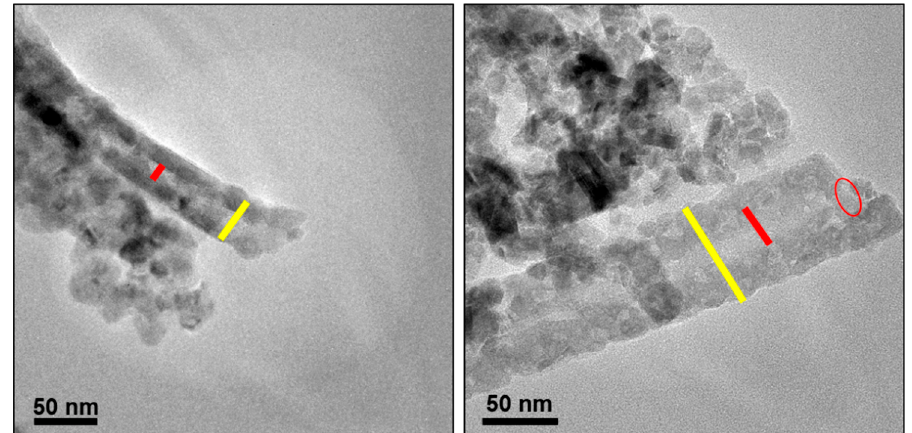
Figure 10. TEM images of the CuCrO 2 hollow nanotubes.